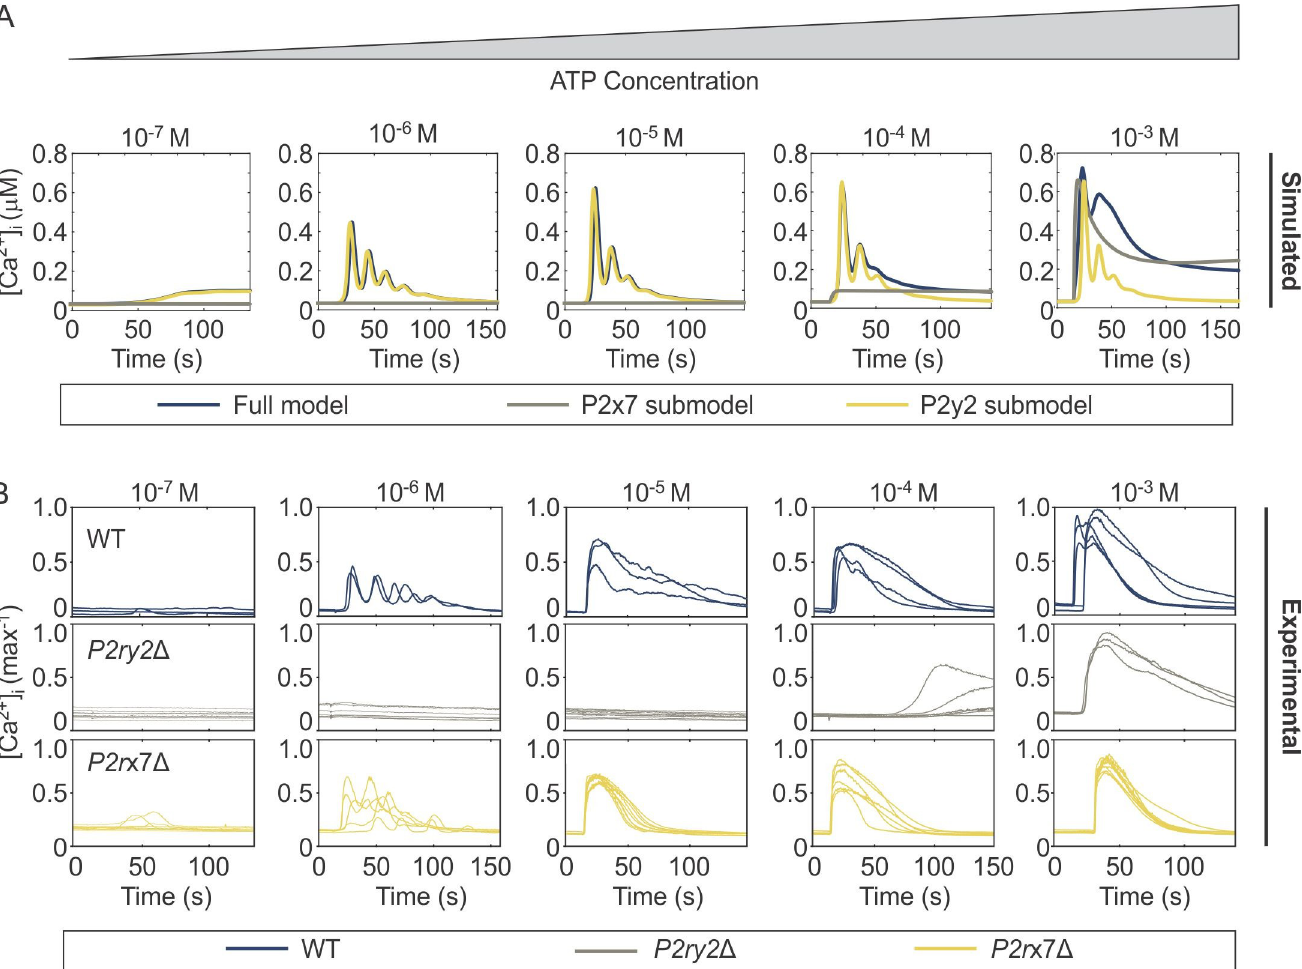
Fig 4. Comparison of simulated and experimental dynamics of ATP-induced [Ca 2+ ] i responses. (A) Time series simulations of [Ca 2+ ] i responses generated by the complete model of P2Y2 and P2X7 (full model, blue ), P2X7 submodel ( grey ) and P2Y2 submodel ( yellow ). Parameter values are provided in Table 1 . (B) Experimental recordings of [Ca 2+ ] i responses in WT ( blue ), P2ry2 Δ ( grey ) and P2rx7 Δ ( yellow ) C2-OB cells in response to varying [ATP].